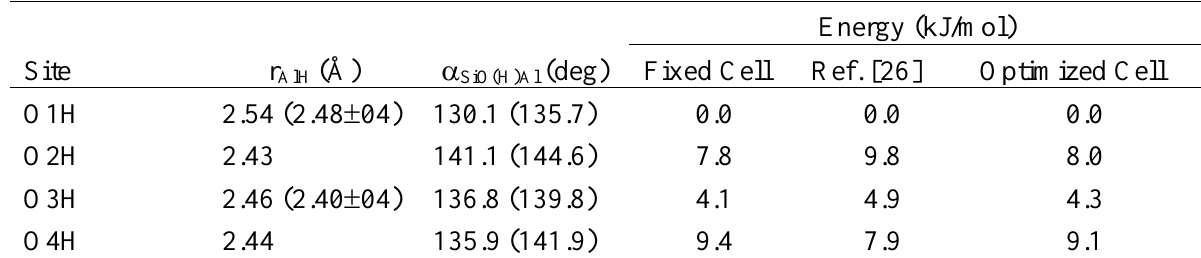
Table 1. Selected geometrical parameters and relative energies of the four bridging OH groups in H- faujasite (FAU). Experimental values are shown in parentheses [25,